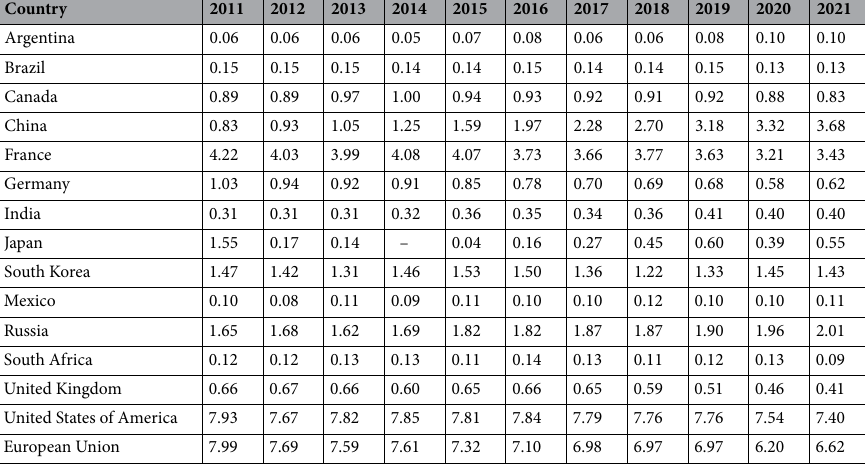
Table 7. Nuclear energy consumption data of G20 countries 47 . All consumption in exajoules.